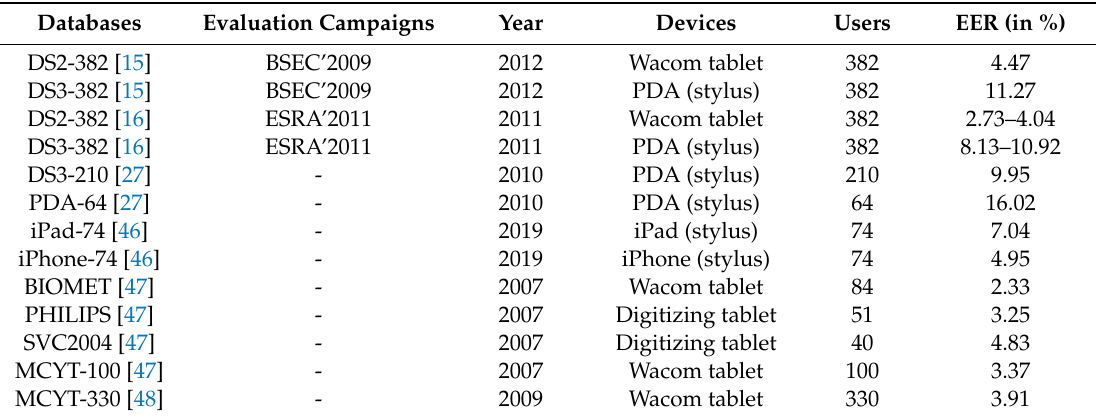
Table 1. Performance of our HMM-based ASV system on several online signature databases